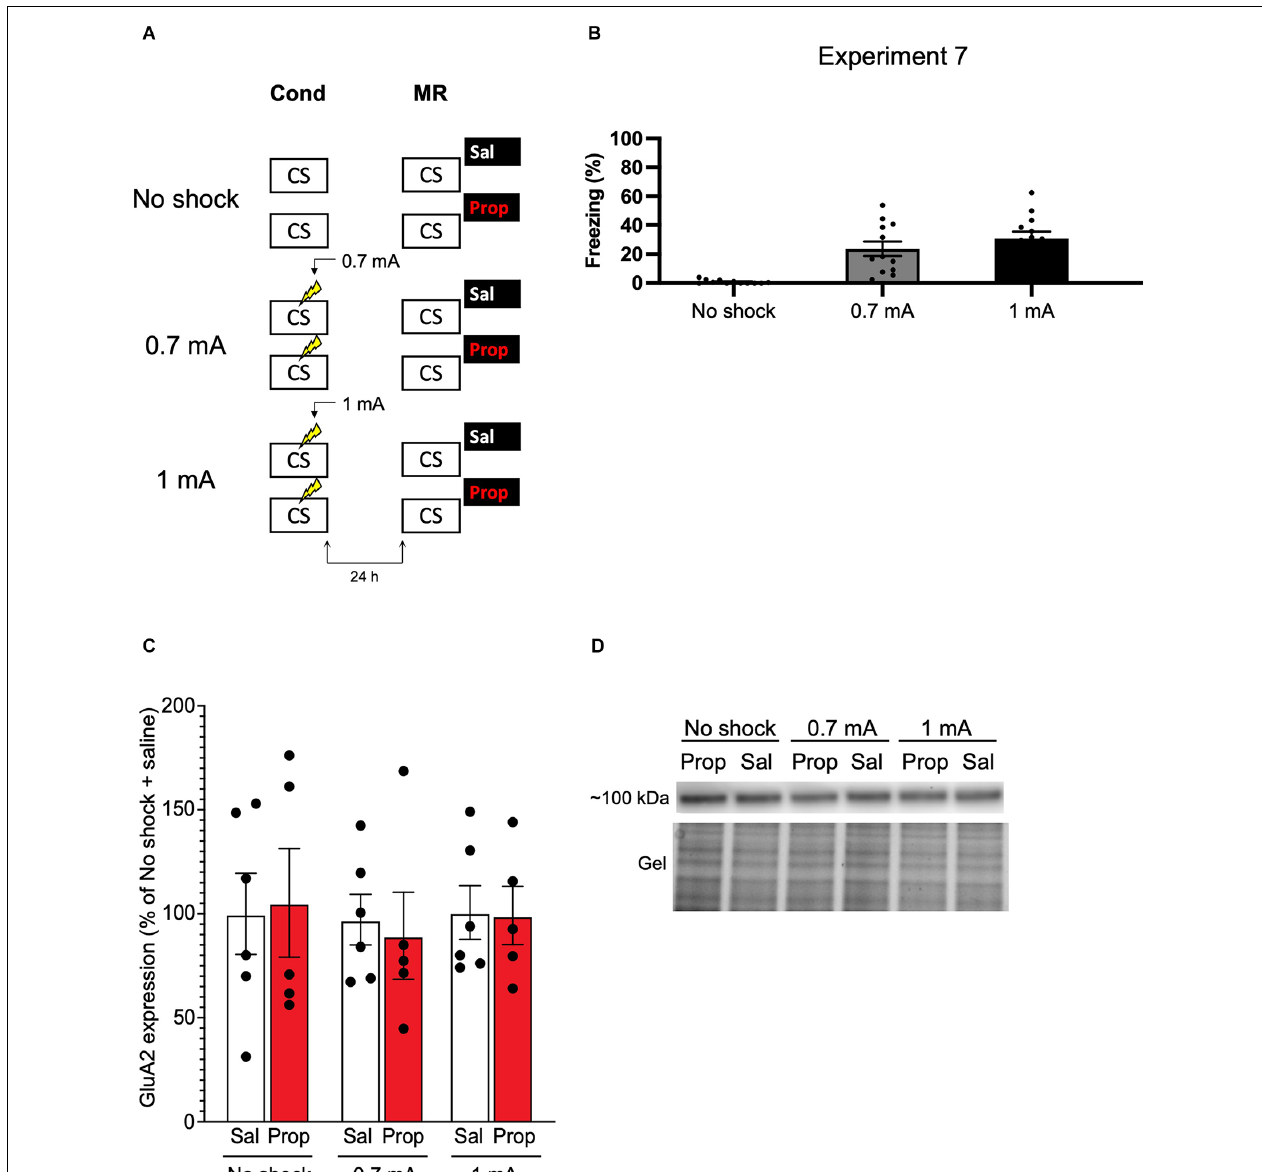
FIGURE 7 | No effect of reactivation on synaptic GluA2 expression. (A) Design of Experiment 7. Mice received either no shock, one 0.7 mA shock, or one 1 mA shock during fear conditioning. One day later, mice underwent memory reactivation and received either saline (no shock, n = 5; 0.7 mA, n = 6; 1 mA, n = 6) or propranolol (no shock, n = 5; 0.7 mA, n = 5; 1 mA, n = 5) afterwards. One hour later the mice were sacrificed. Cond, conditioning; MR, memory reactivation; CS, conditioned stimulus (context); Sal, saline; Prop, propranolol. (B) Freezing levels during reactivation for the no shock group (left), 0.7 mA group (middle, dark gray), and 1 mA (right, black) group. (C) Results of Experiment 7. GluA2 expression levels relative to the no shock + saline control group (saline in white bars, propranolol in red bars). Error bars represent SEM. Filled circles indicate individual animals. (D) Upper panel: representative immunoblots for GluA2 with approximate molecular weight indicated. Lower panel: corresponding gels of total protein that were used for